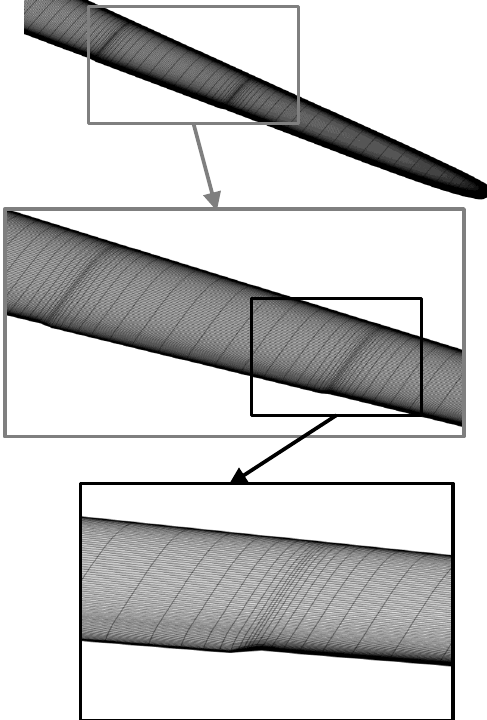
Figure 5. Methodology for 3-D deflection.